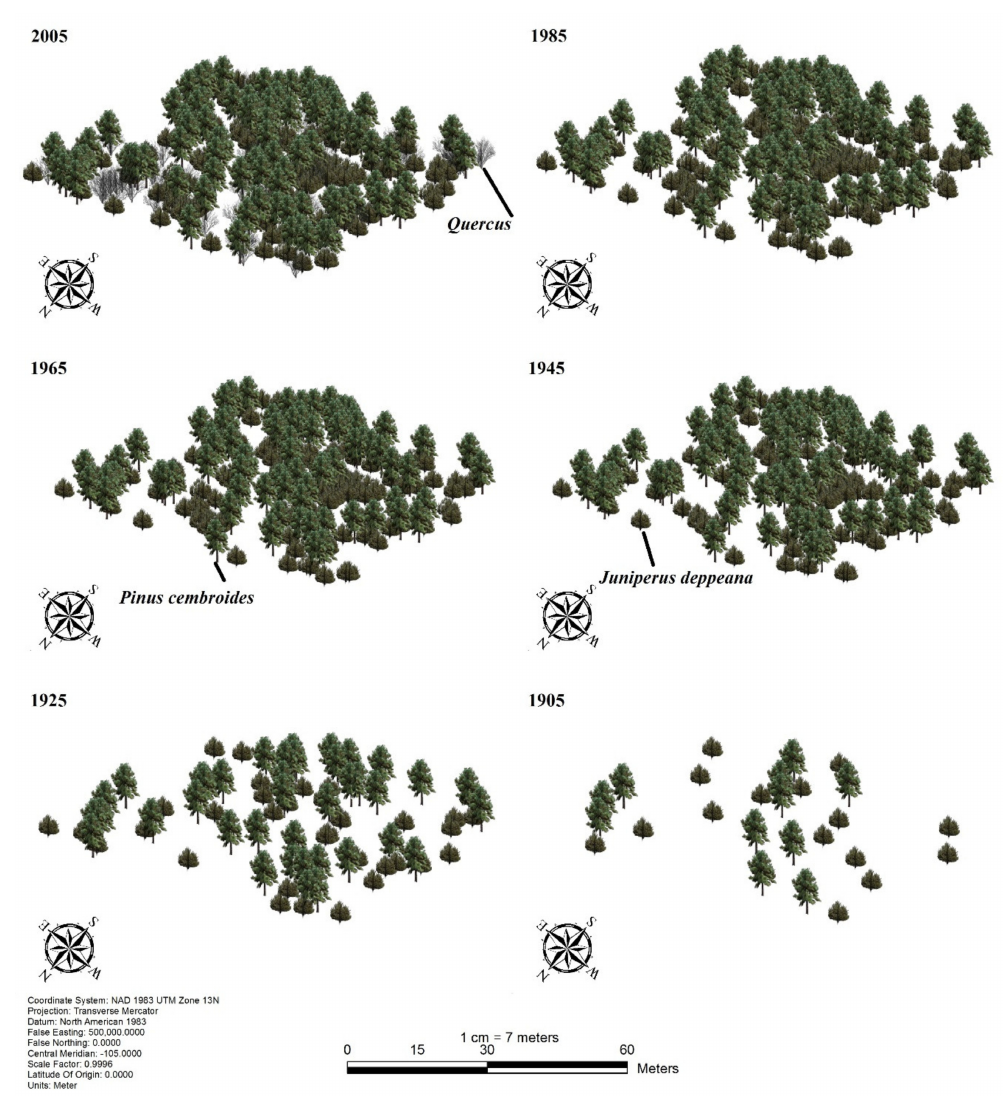
Figure 3. Spatial pattern of Mexican piñon ( Pinus cembroides var. cembroides Zucc.), alligator juniper ( Juniperus deppeana var. deppeana Steud.), and oak species ( Quercus spp. L.) within study site 2 in 1905 through